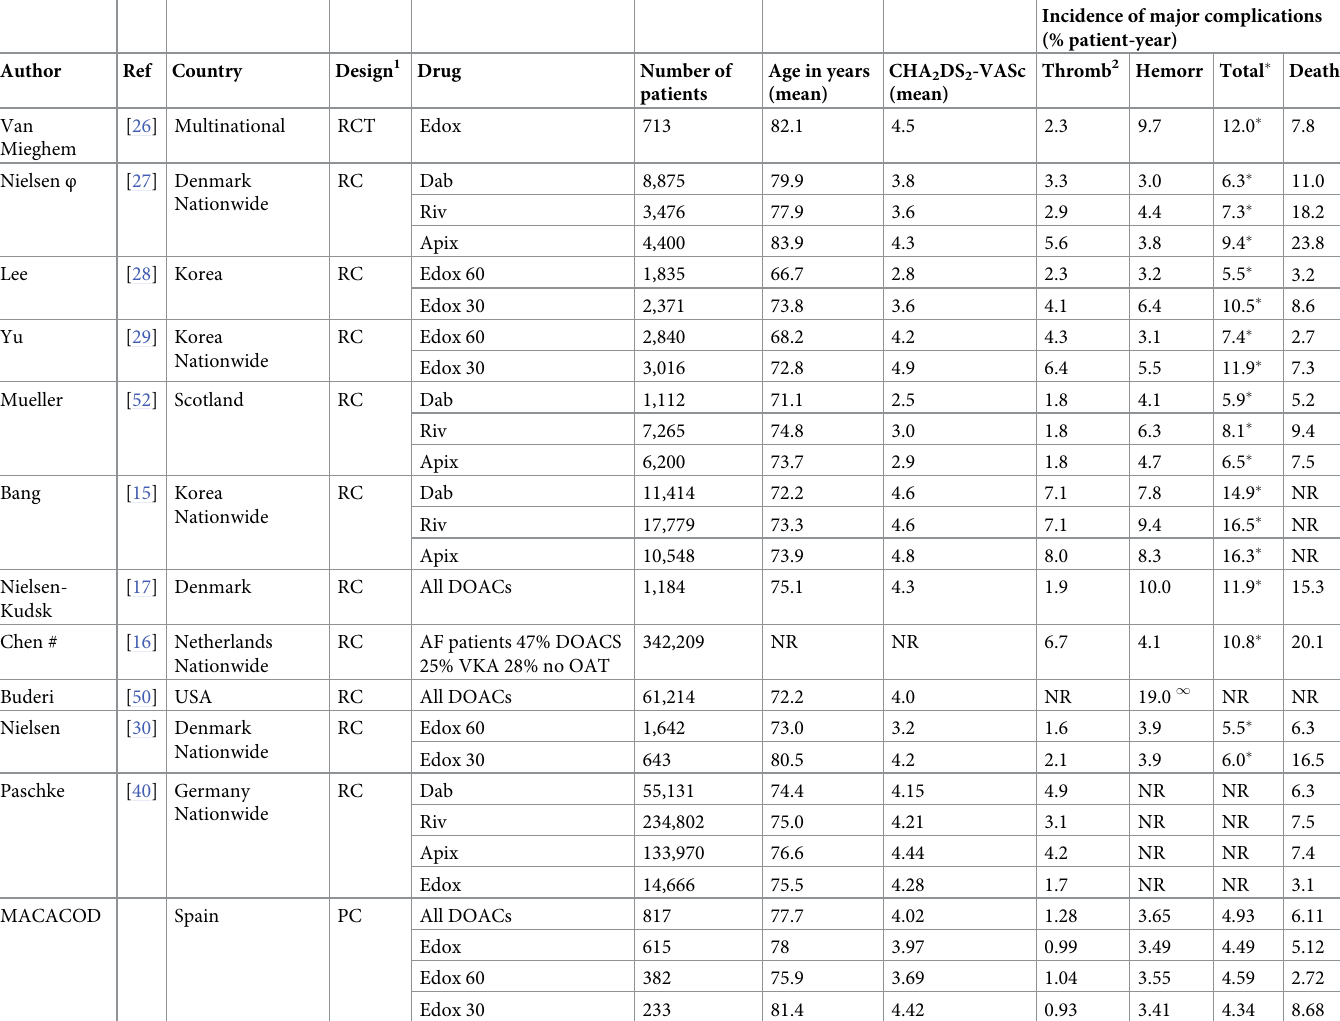
Table 5. Main outcomes with DOACs from studies reporting a similar or higher incidence of major complications than